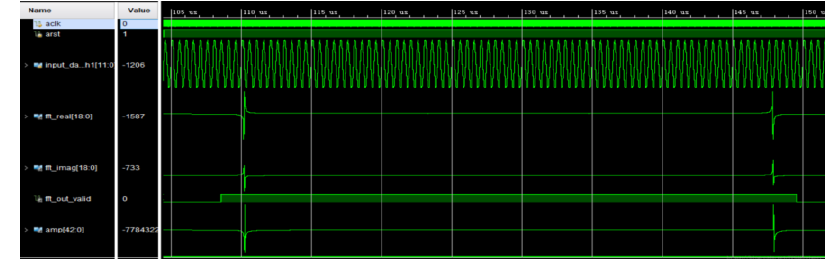
Fig. 5. Radix-2 FFT simulation of 2MHz signal.